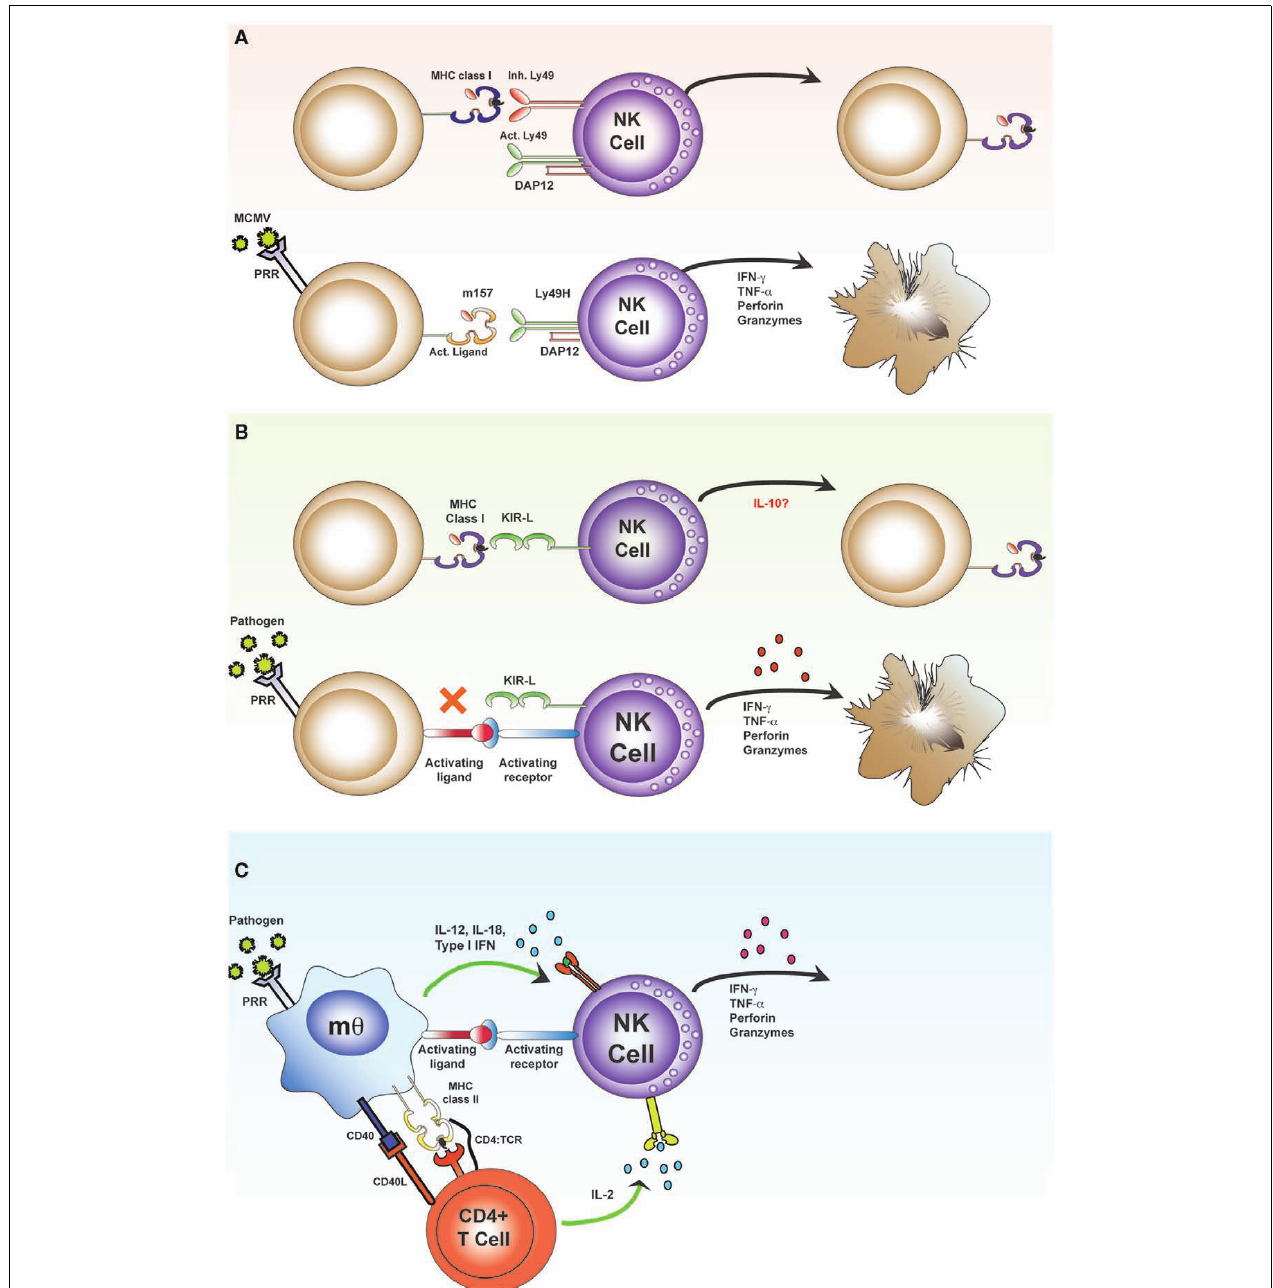
molecules, and direct killing of target cells. Activating ligands include stress-induced ligands on infected or transformed cells and virus-encoded ligands. For example, during infection with murine cytomegalovirus (MCMV), the activating receptor Ly49H recognizes the MCMV-derived MHC class I-like molecule, m157, which leads to direct killing of MCMV-infected target cells [ (A) ; lower panel].The “indirect” pathway of NK cell activation results from contact-dependent and soluble signals derived from accessory cells andT cells transmitted to activating receptors on NK cells (C) . Myeloid accessory cells recognize pathogens via PRRs, secrete cytokines, and upregulate co-stimulatory molecules. Accessory cells also present antigen to CD4 + T cells and provideT cell co-stimulation; activatedT cells secrete IL-2 which synergizes with accessory cell signals to potentiate the activation of NK